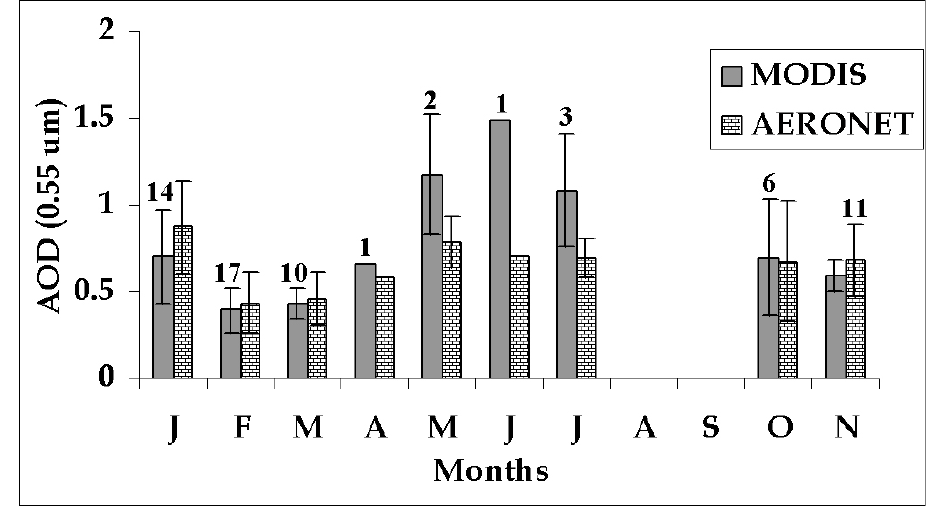
Fig. 2. Monthly averaged AOD at 0.55 µ m wavelength over Kanpur during the year 2004 retrieved from MODIS and AERONET. The error bars represent the standard deviation of AOD for that month. Numbers above the histogram of MODIS derived AOD represent the number of data points for the respective month.